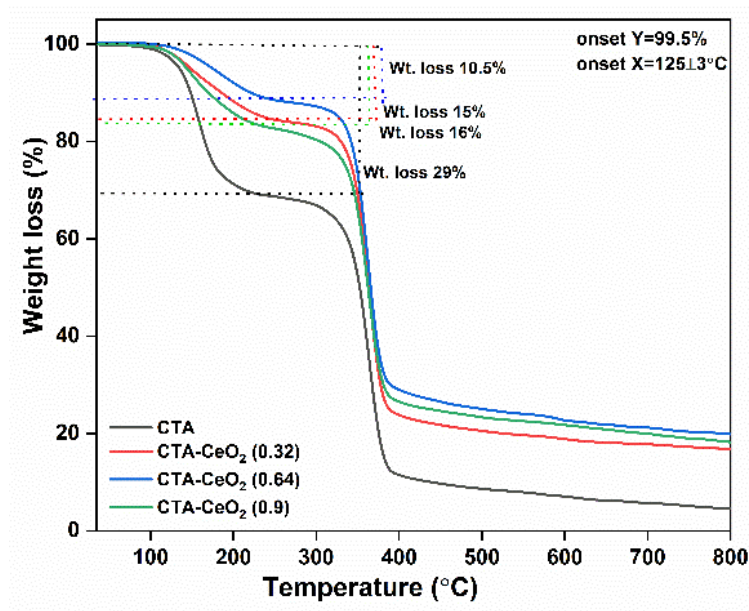
Figure 7. TGA thermogram of the pristine CTA and CTA-CeO 2 MMMs. Furthermore, to measure the thermal stability of the CeO 2 nanoparticles only, TGA- DTG thermogram analysis was carried out (Figure S6). The results show a maximum weight loss of 3%, with major weight loss at around 40 ◦ C. This is primarily due to the loss of water held on the surface by hydrogen bonding. The second minor weight loss peak at about 200 ◦ C could be due to the loss of non-dissociative adsorbed water. The effect of using CeO 2 nanoparticles as fillers on the mechanical properties of the CTA MMMs depends on the polymer-particle interface properties. The mechanical tensile test results are shown in Figure 8 and Table 2. The pristine CTA exhibited a Young’s modulus of 1.24 GPa, an elongation strain of 51.29% and a tensile strength at break of 31.09 MPa. The addition of CeO 2 to CTA MMMs increased both the tensile strength and Young’s modulus. With the incorporation of CeO 2 nanoparticles, in contrast to pristine CTA properties, the strain drops unilaterally while the modulus increases to different extents, suggesting an efficient interphase load transport between phases during tension due to the high compatibility between the polymer and filler. The Young’s modulus of MMMs reaches a maximum at a filler loading of 0.64%. As the filler loading increases to 0.9%, the modulus of the membranes falls, probably due to poor compatibility between the CeO 2 nanoparticle fillers and the CTA polymer matrix, leading to the failure of the transfer of the external force from the polymer matrix to the fillers. Similarly, at such a high filler concentration, some particles are likely to aggregate, resulting in decreasing compatibility between the CTA matrix and filler particles, which could reduce the modulus and the tensile strength of the MMMs from the discontinuous stress distribution during tension [40,45]. Damping of the synthesized pristine CTA and MMMs is illustrated in Figure 9. Two peaks can be observed for every sample, with the major peak centered at 188.5 ◦ C and a broad shoulder peak in between 100 and 175 ◦ C. The shoulder peak is presumed to be caused by the relaxation between the crystalline and amorphous phases [46]. Tan